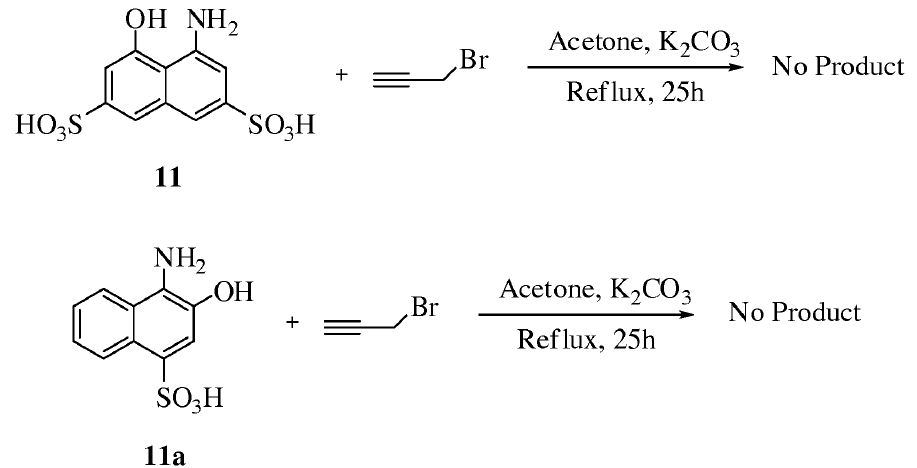
Fig. 6. Synthesis of compounds 12a–b .